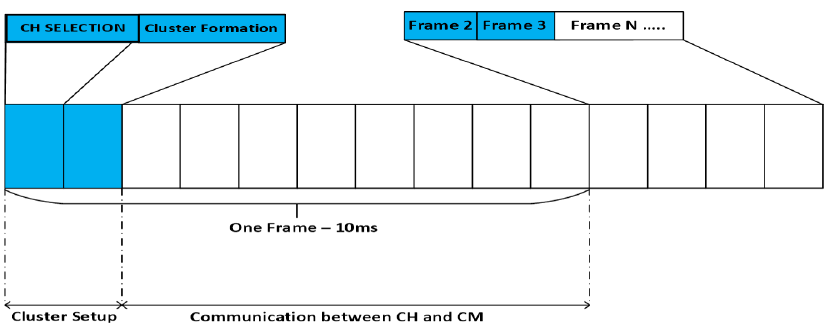
Figure 7. Frame structure for clustering.